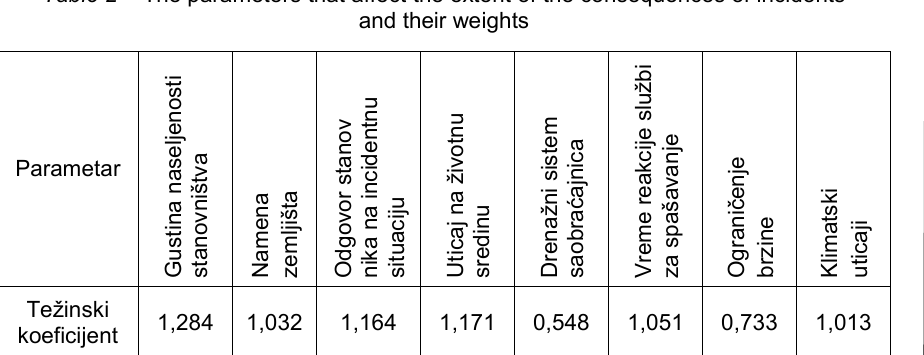
Table 2 – The parameters that affect the extent of the consequences of incidents